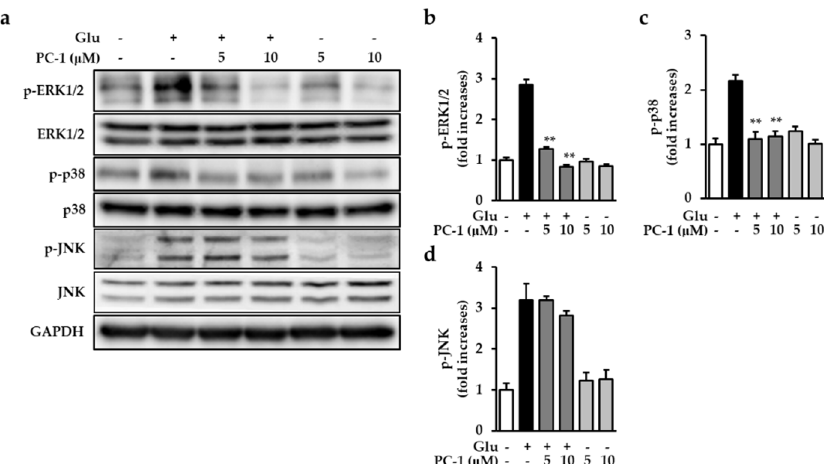
Figure 6. Procyanidin C1 inhibits glutamate-induced MAPK activation in HT22 cells. ( a ) HT22 cells were exposed to 5 mM glutamate in the presence or absence of 5 or 10 µ M PC-1 for 8 h, and western blot analysis was performed using antibodies for ERK1 / 2, p38, and GAPDH. The GAPDH was used for loading control. ( b – d ) Bars indicate the fold-increases of ERK1 / 2, p-38, and JNK phosphorylation compared with the control cells. Data are presented as the mean value ± S.E.M. ** p < 0.001 versus glutamate-treated HT22 cells.